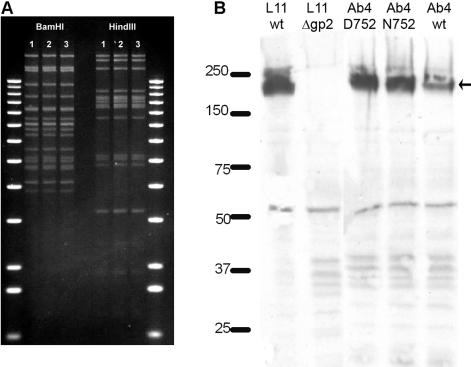
Viral Mutagenesis(A) Genomic restriction fragment patterns of the wild-type Ab4 strain (lane 1), the N752 mutant (lane 2), and the revertant D752 (lane 3) were analyzed to verify that no gross rearrangements had occurred during mutagenesis (marker, 1-kb ladder [Invitrogen]).(B) Expression of the glycoprotein restored in place of BAC sequences (gp2, 250 kDa, indicated by arrow) in all constructs was confirmed by Western blot analysis, with EHV-1 strain RacL11 (with and without gp2 [29]) and the parental Ab4 BAC as controls (marker, Precision Plus [Bio-Rad]). Mutant virus constructs were also sequenced in the region of interest at each passage level, including after reisolation from horses.